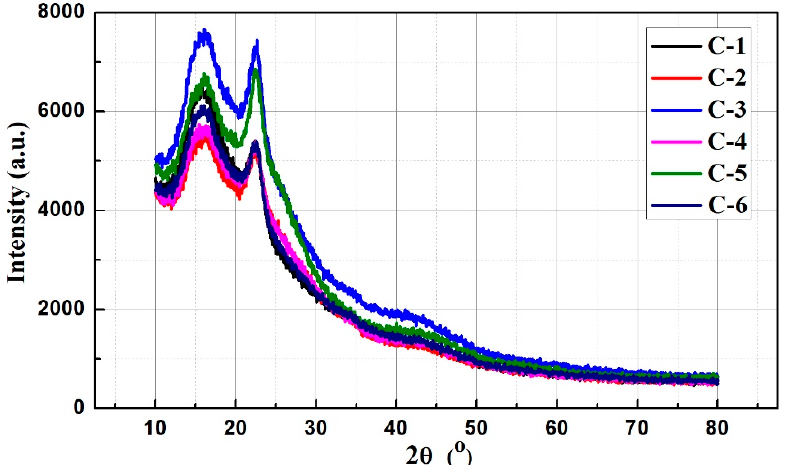
Figure 4. X-ray diffraction ( XRD) patterns of the PAN-derived carbon nanofiber mats treated at various thermal stabilization and carbonization temperatures.